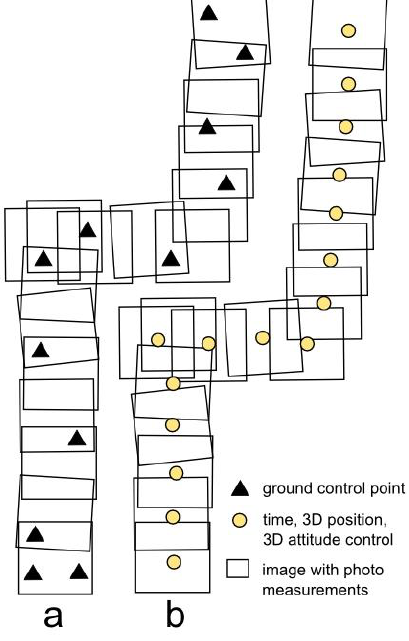
Figure 1. A schematic sketch of corridor mapping